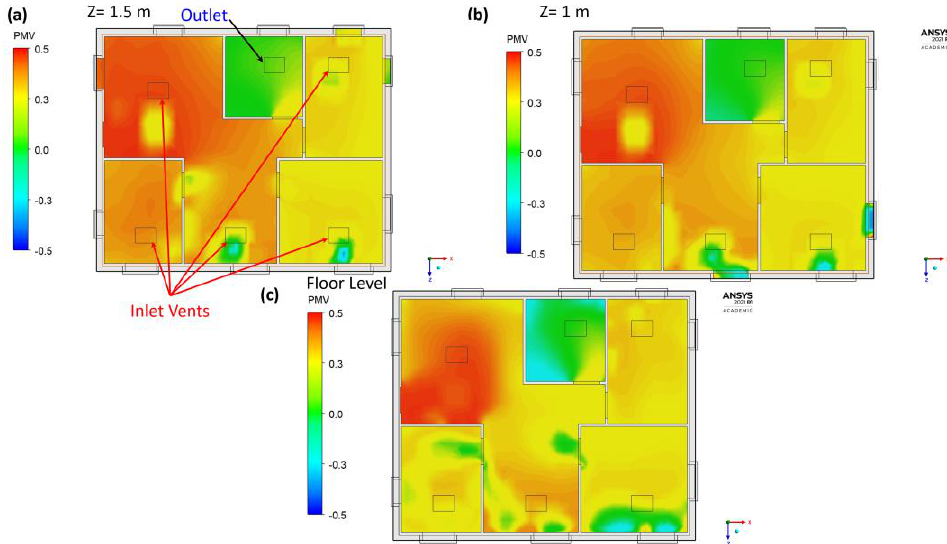
Figure 9. The predicted mean vote (PMV) profiles distribution for the house (top view) using ASHRAE 55-2017 inlet temperature 25 ℃ at different heights ( a ) 1.5 m, ( b ) 1 m, and ( c ) the (finished) floor.